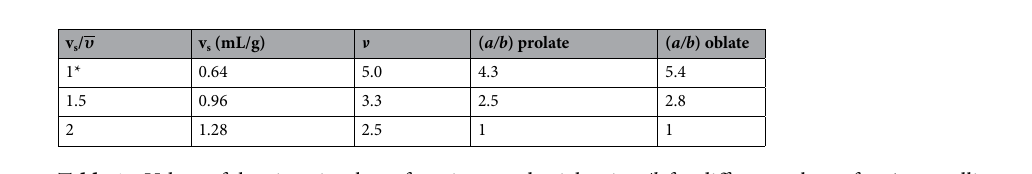
Table 1. Values of the viscosity shape function ν and axial ratio a/b for different values of v s . *no swelling through dynamic hydration effects. v s swollen specific volume, υ partial specific volume (0.64